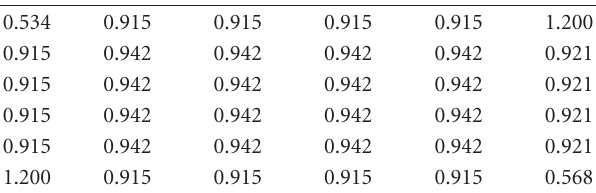
Table 4: k -factors for the mixing